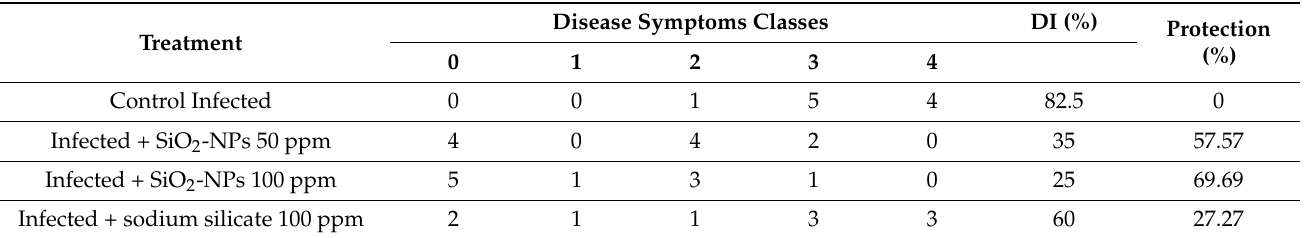
Table 1. Effect of SiO 2 -NPs and SiO 2 on A. solani early blight disease index of S. melongena